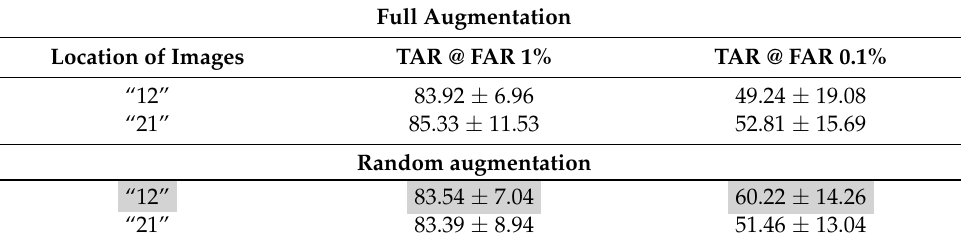
Figure 5. ROC curves for individual databases for the VTI method. Table 7. Test results for different sample image and test image positions for the VTI method for the Inception-v3